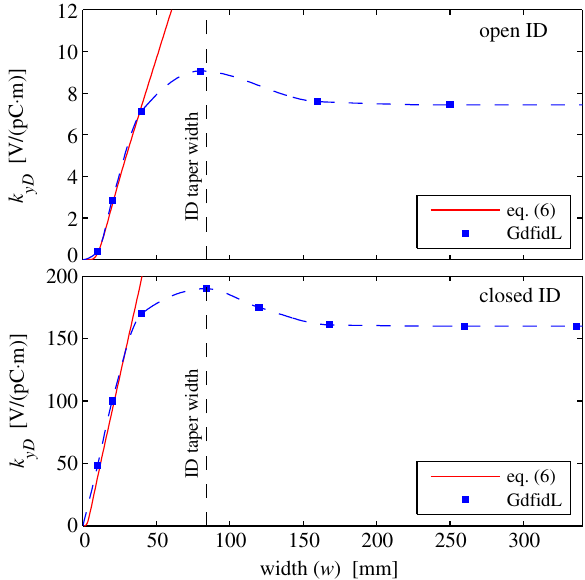
FIG. 7. Dipole vertical kick factor — width dependence calculated for b ¼ 15 mm (upper plot) and for b ¼ 2 . 5 mm (lower